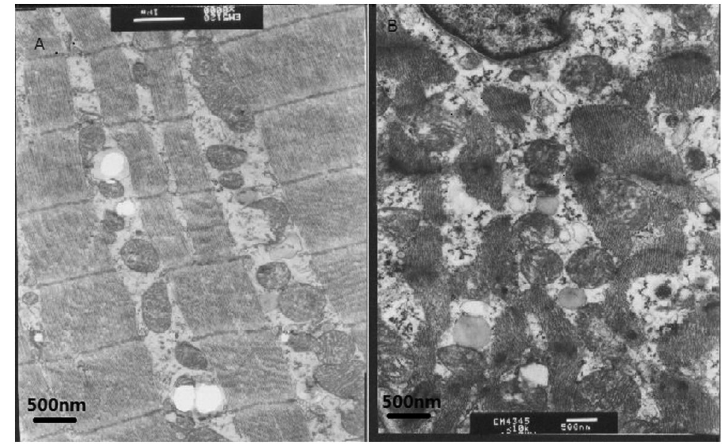
Figure 2. Representative photomicrography of ventricular myocardium from control ( A ) and pacing ( B ) dogs obtained by electron microscopy. Panel B shows disorganized structures: myocar- dial fiber hypertrophy, disordered myofilaments, edema, damaged striated muscle framework, disrupted myocardial fibers, unclear Z lines, disrupted and engorged mitochondrial mem- branes, rarefaction of cristae, vacuolization, distended sarcoplasmic reticulum, and interca- lary disc abnormalities, which did not occur in the control